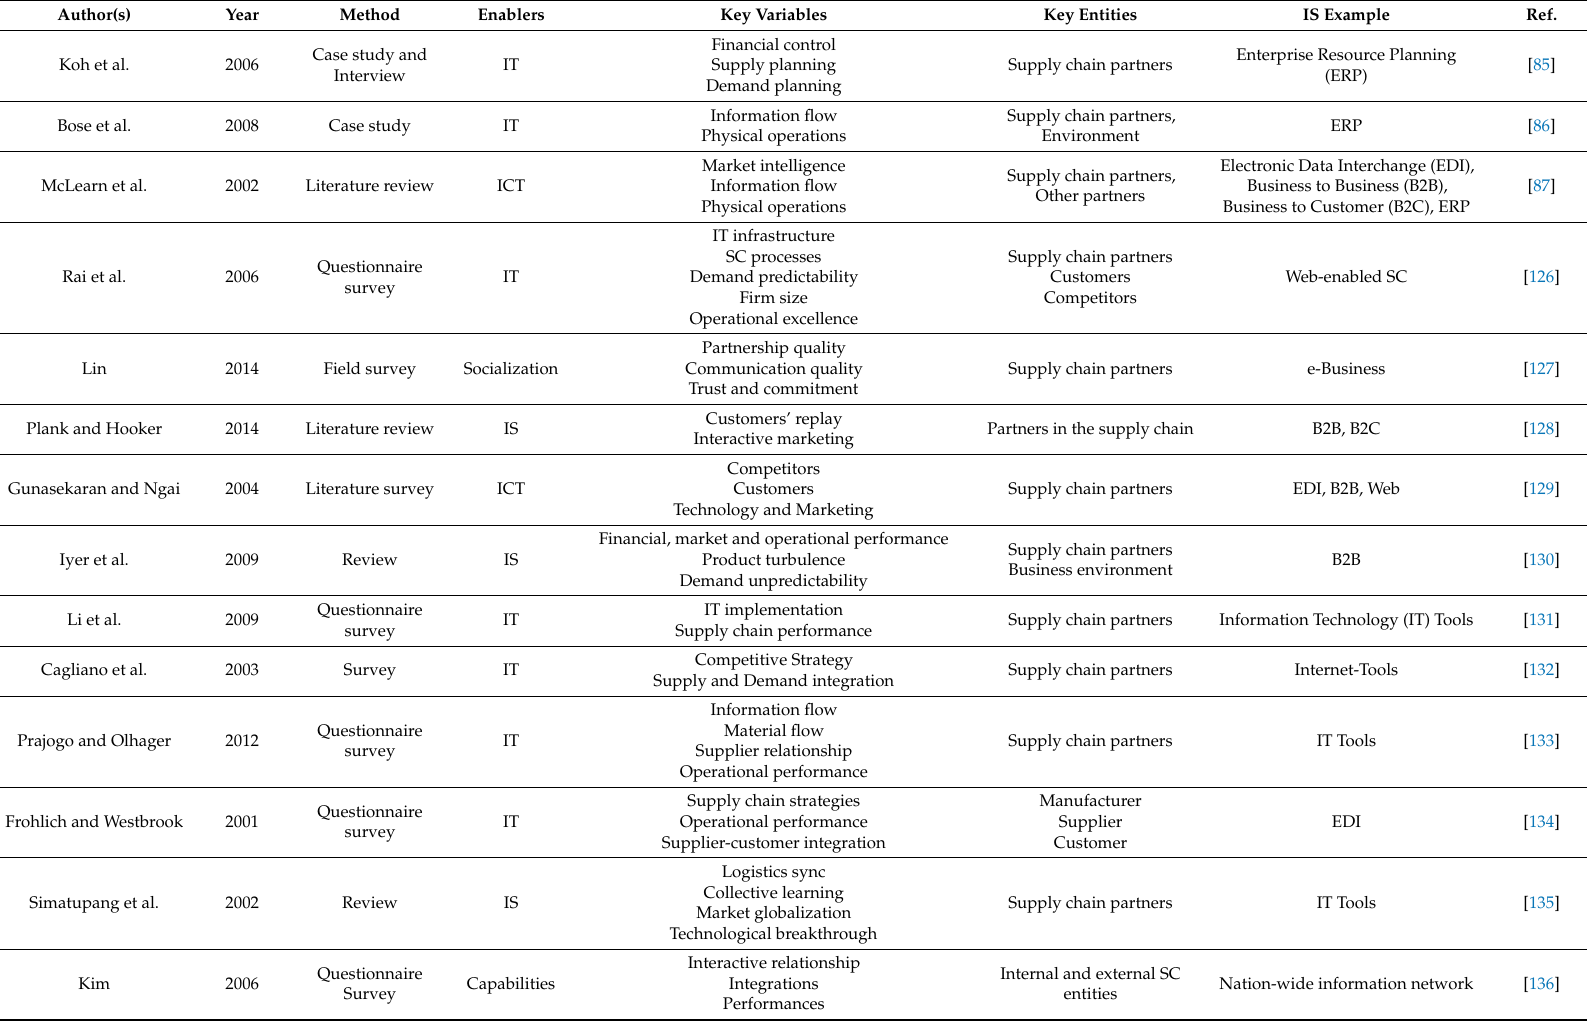
Table 3. Reviews on integration enablers and key integration areas for better supply chain (SC)